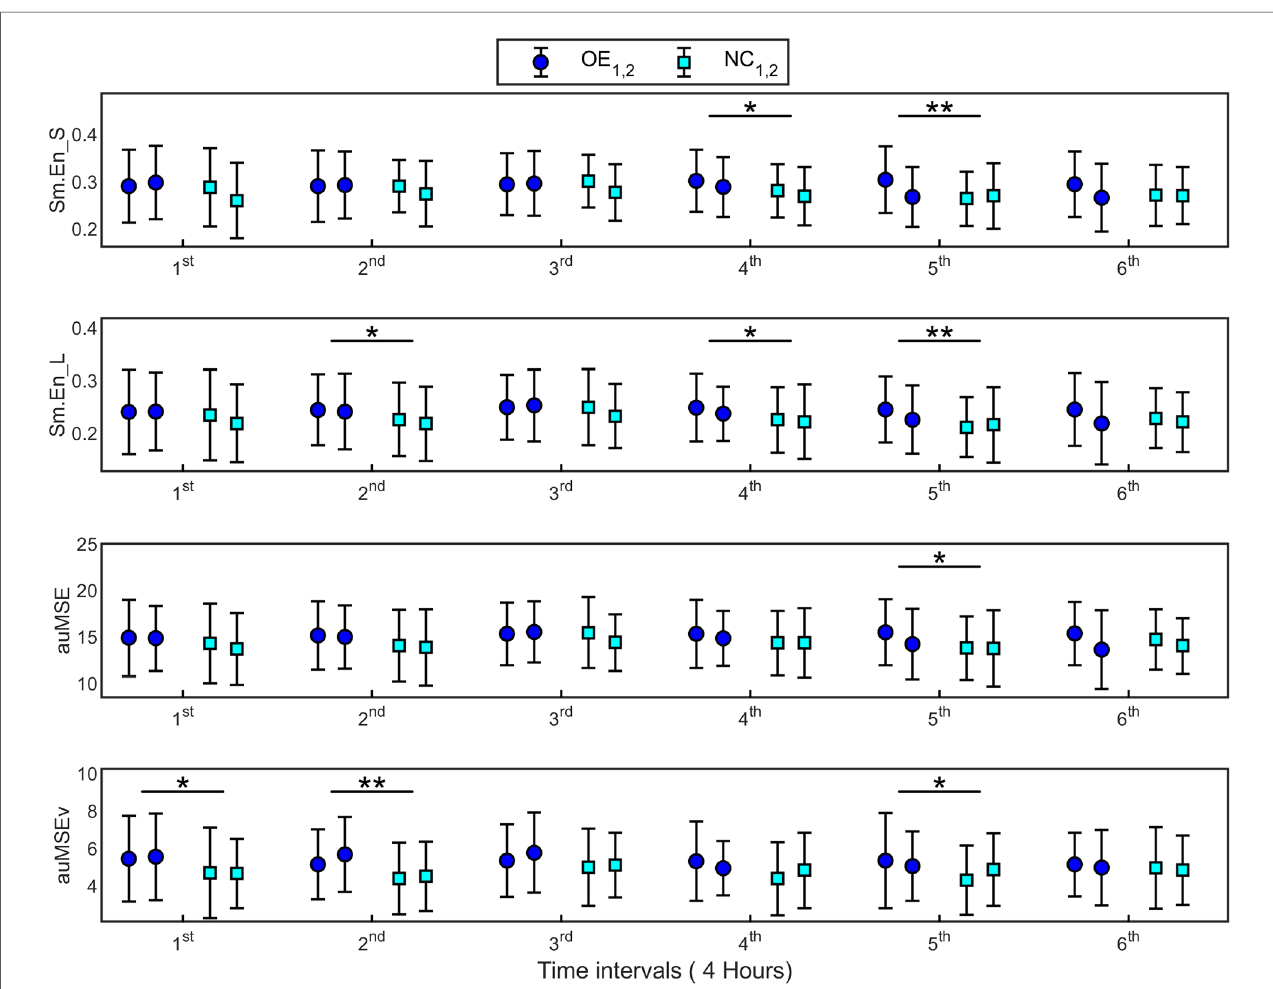
FIGURE 5 Signal irregularity and complexity measures (mean±SD) estimated at 6 time points of 4 h each over 24 h, for supplementations OE and NC. Error bars with the same colored marker refer to measures for the fi rst and second applications of the supplementations (OE 1,2 and NC 1,2 ). 1st time interval refers to 0 – 4 h, 2nd time interval is 4 – 8 h and so on. The signi fi cant differences observed between supplementations at speci fi c time points are marked. * p <0.05, ** p